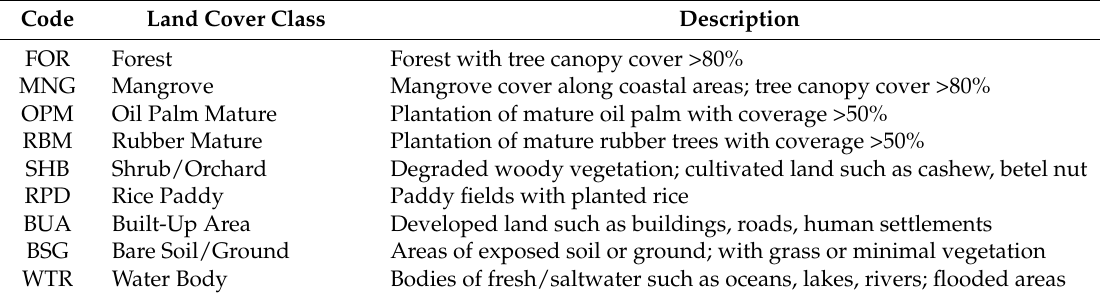
Table 1. Description of the land cover classes of the Tanintharyi Region, Myanmar.